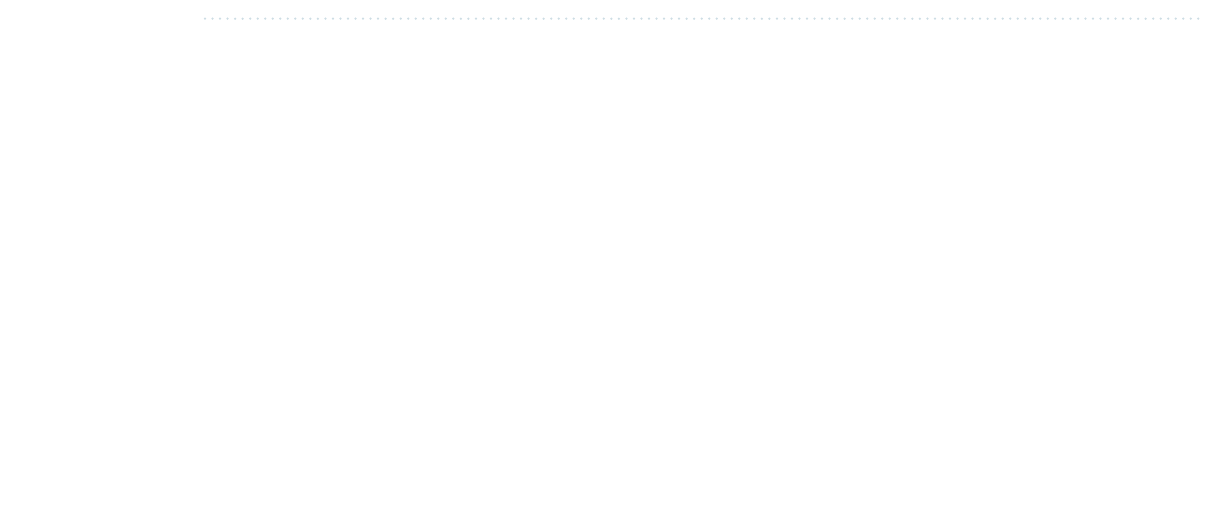
Figure 2. The change of IGD value of all algorithms in 16